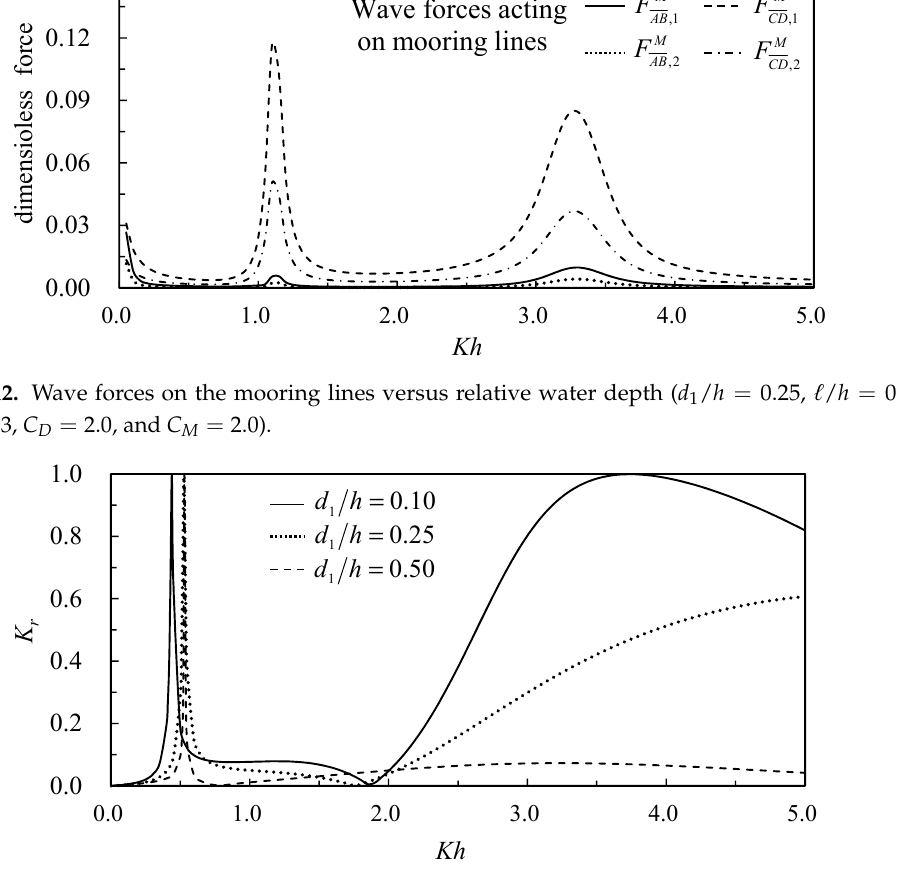
structure ( d 1 / h = 0.10, 0.25, and 0.50). structure ( 𝑑 (cid:2869) / ℎ = 0.10, 0.25,and 0.50 ).